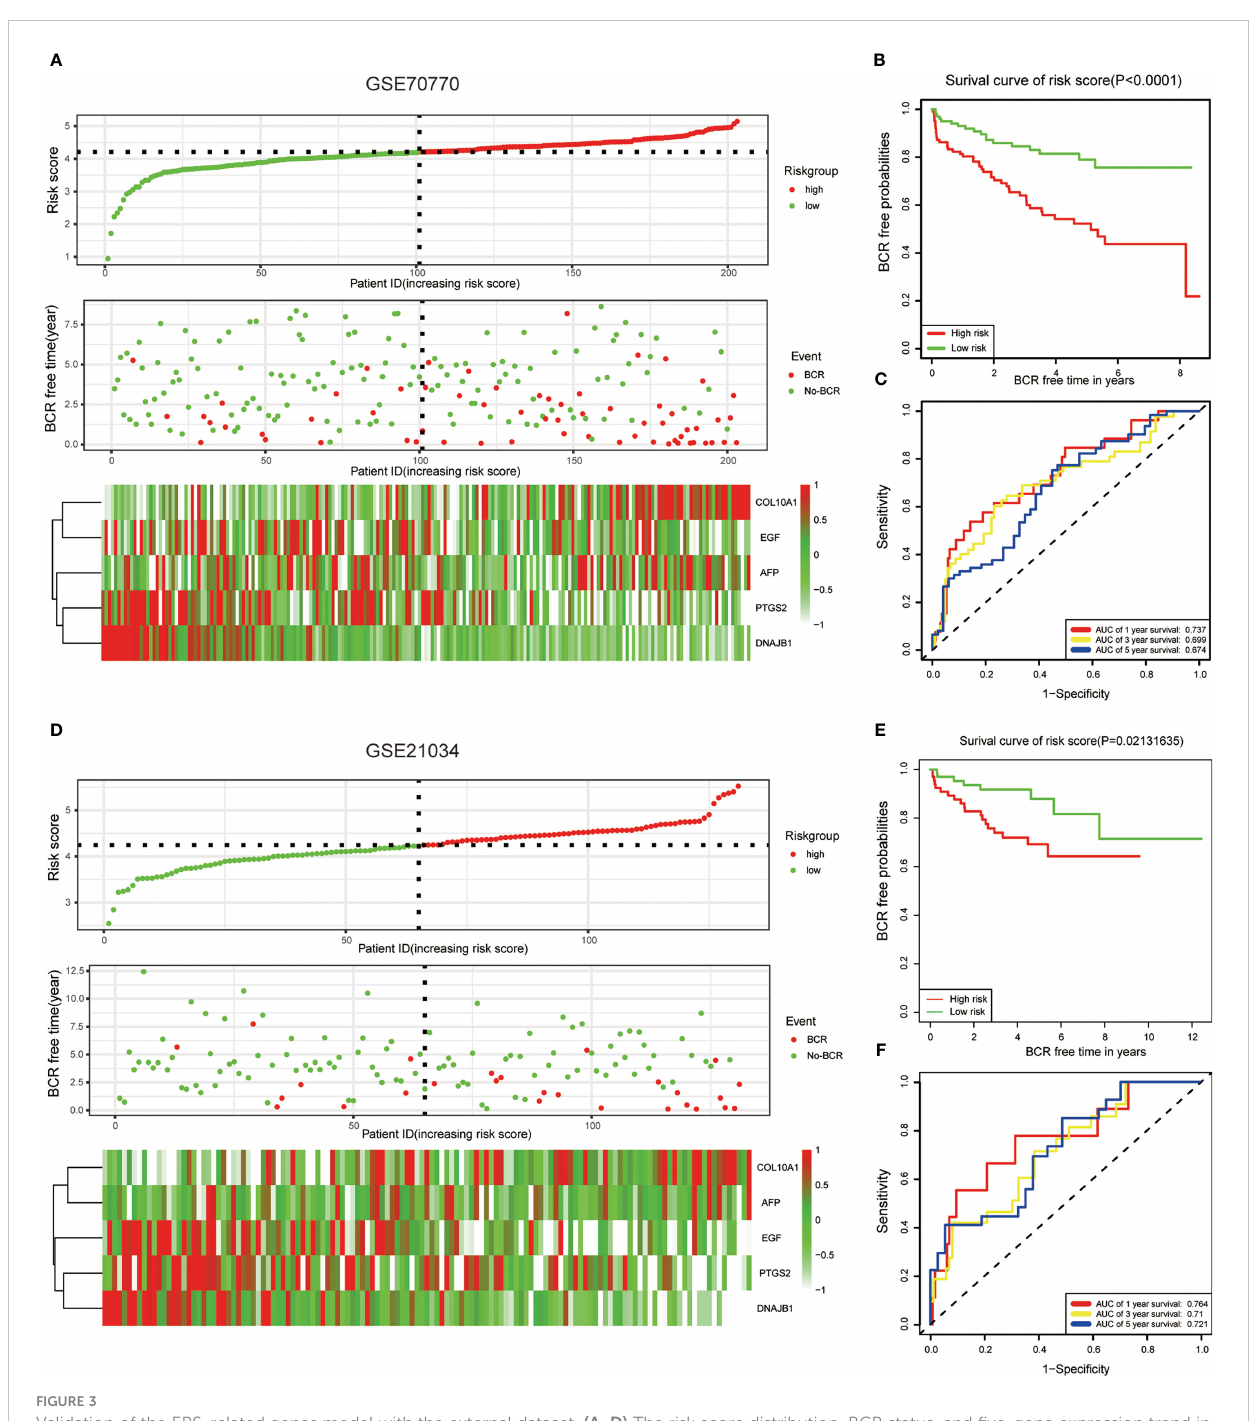
FIGURE 3 Validation of the ERS-related genes model with the external dataset. (A, D) The risk score distribution, BCR status, and fi ve-gene expression trend in GSE70770 and GSE21034. (B, E) KM survival curve of the fi ve-gene signature model in GSE7070. (C, F) ROC curves for BCR-free survival prediction models at 1, 3, and 5 years. The risk score in both datasets was calculated by the same formula and divided into high-risk and low-risk groups based on the median risk